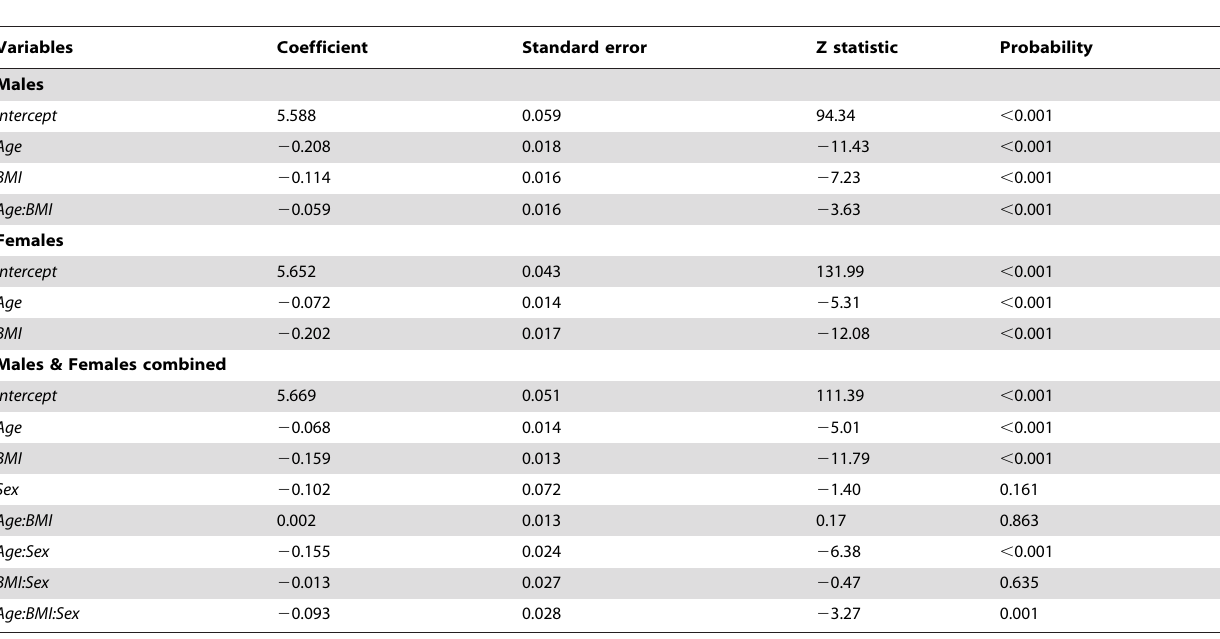
Table 5. Coefficients showing the influence of age, BMI and sex on blood